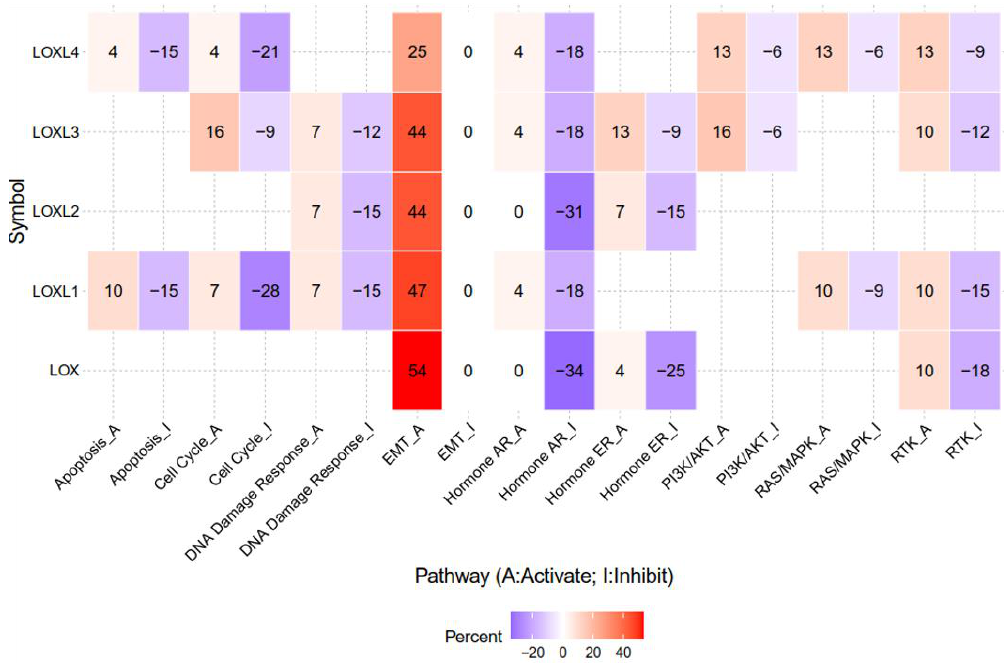
Figure 2. The epithelial–mesenchymal transition (EMT) pathway is activated by LOX, LOXL1, LOXL2, LOXL3, and LOXL4 in genomic big data-centric pathway analysis. Heatmap data demonstrated that LOX, LOXL1, LOXL2, LOXL3, and LOXL4 have activating/inhibiting (red/blue) functions on each cancer-related pathway. Note that LOX, LOXL1, LOXL2, LOXL3, and LOXL4 account for 54%, 47%, 44%, 44%, and 25% of cancers in the EMT-activating pathway, respectively. The pathway activity module was assessed with the GSCALite web server. High-throughput antibody-based technique reverse phase protein array (RPPA) was conduct to determine the expression of The Cancer Genome Atlas (TCGA) samples of at least 5 cancer types. Known cancer-related pathways are included: TSC/mTOR, RTK, RAS/MAPK, PI3K/AKT, hormone ER, hormone AR, EMT, DNA damage response, cell cycle, apoptosis.